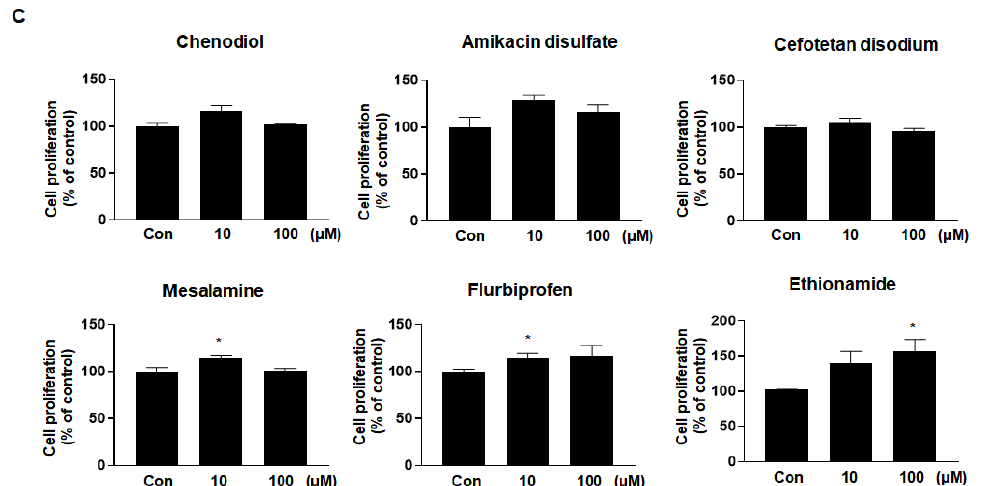
Figure 1. Ethionamide was selected to promote the proliferation of mesenchymal stem cells (MSCs). ( A ) Experimental design of drug library screening. MSCs were exposed to a drug library consisting of 850 FDA-approved compounds, and ethionamide was selected after two screenings. ( B ) MSCs were treated with 10 μM of drugs and the cell viability was measured by ATP assay. Six drugs were selected as a result of the first screening (cut off ≥125%). ( C ) Cell proliferation was measured by BrdU assay after treating MSCs with 10 μM and 100 μM of six drugs. The results obtained from three independent experiments were expressed as a percent of untreated control ± SEM; * p < 0.05 vs. untreated control.